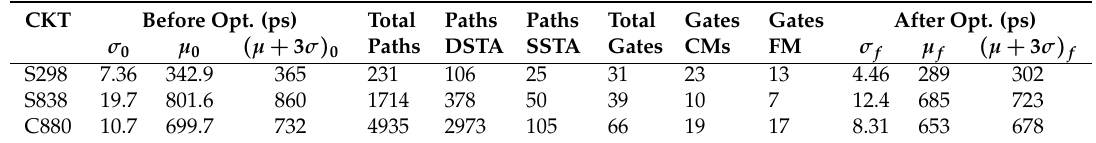
Table 1. Step by Step of process optimization for ISCAS 85 Benchmark Circuits (CMs = Coarse Metrics and FM = Fine Metric).